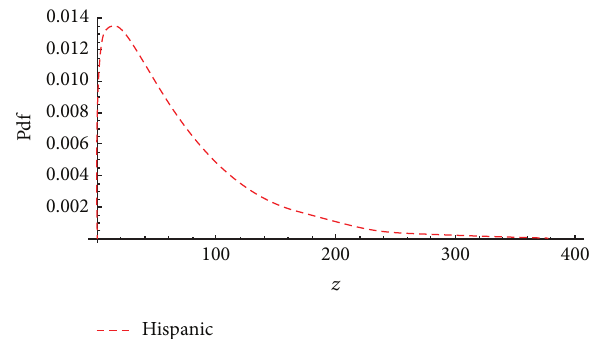
Figure 7: The predictive density for a single future response for Black Hispanic survival